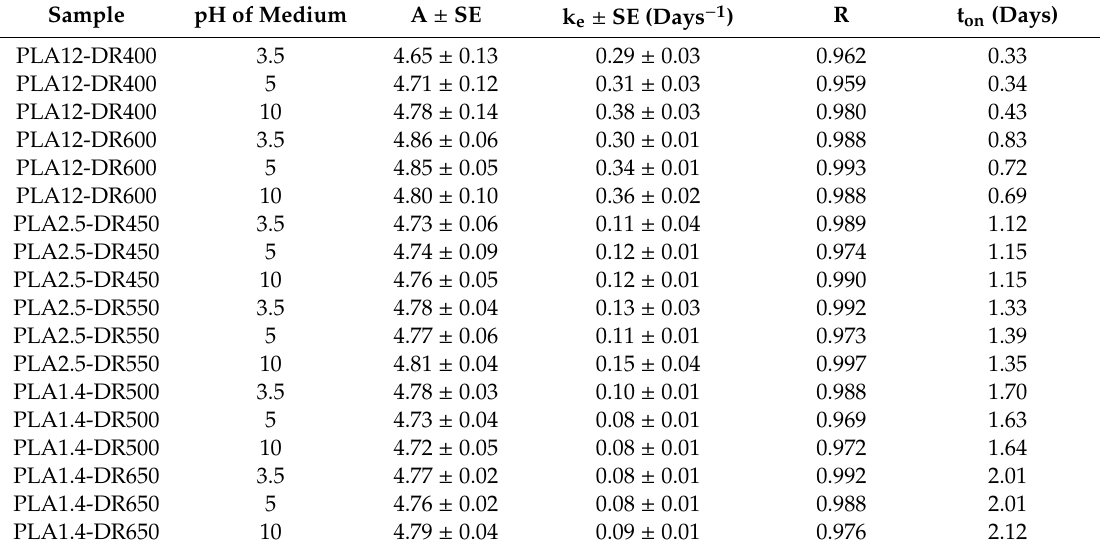
Kinetic parameters of the mass percent remaining of the studied samples during thermal-supported hydrolytic